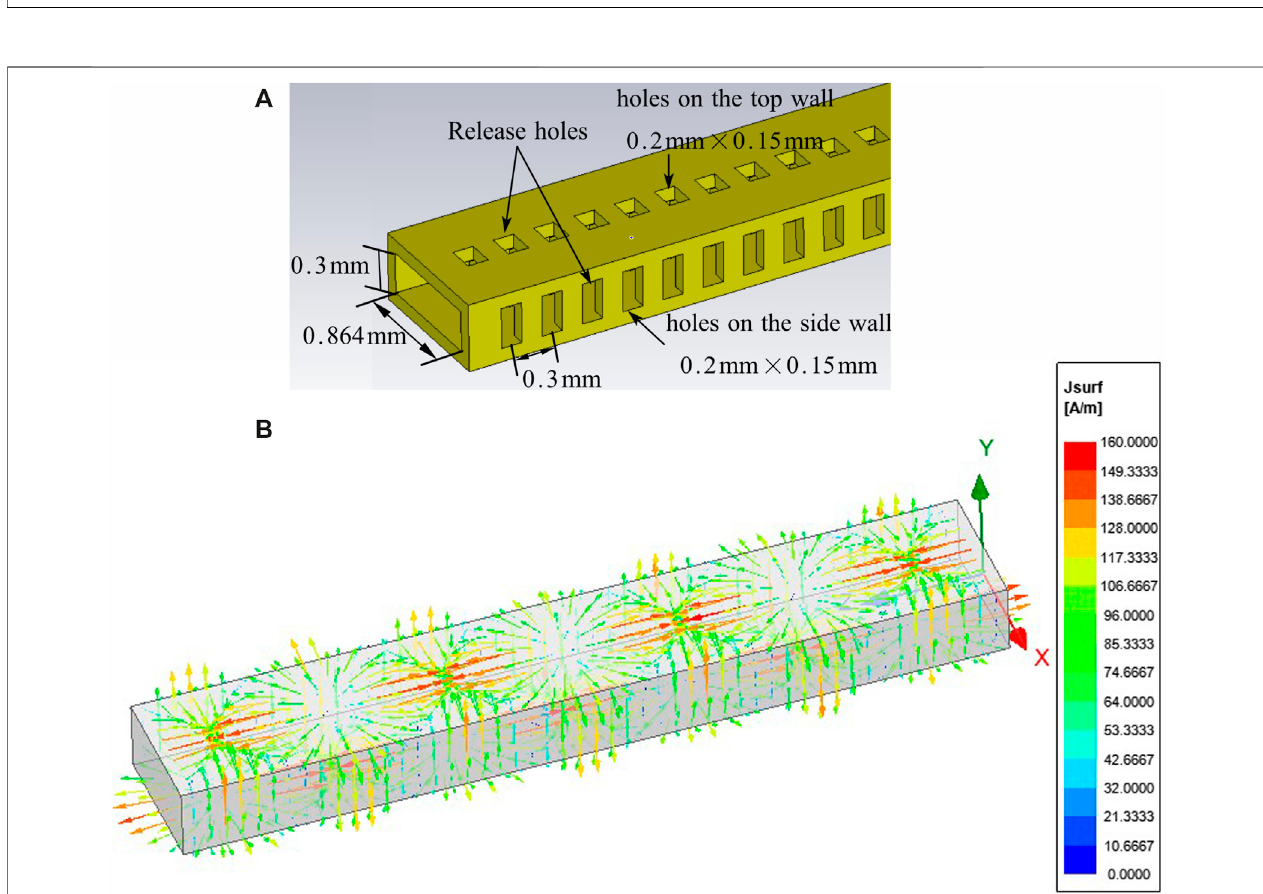
FIGURE 3 | Structure of WR-3 waveguide and its surface current distribution. (A) Simulated model. (B) Current distribution